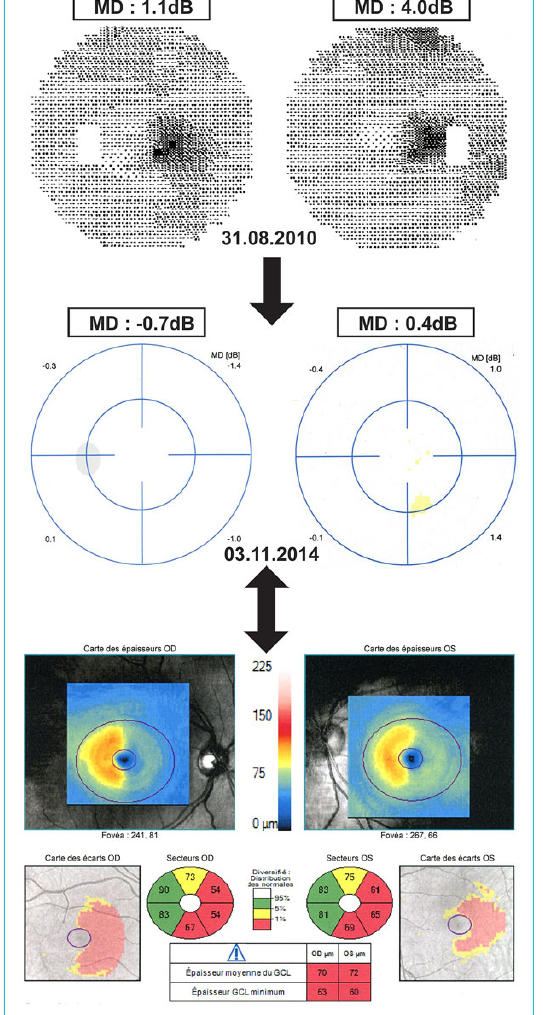
Figure 5: Persistence of homonymous retinal ganglion cell layer thinning after normalisation of the visual field. Top – initially (31 Au- gust 2010), the patient presented with a partial right homonymous scotoma and the mean defect (MD) was moderately elevated in both eyes. Middle – 4 years later (3 November 2014), the visual field was completely normal, with a normal MD in both eyes. Bot- tom – despite a full recovery of visual field, optical coherence to- mography on 3 November 2014 showed a homonymous thinning of the retinal ganglion cell layer, visible on the thickness maps, the deviation maps and the sector maps. MD = mean defect ex- pressed in decibels (dB).